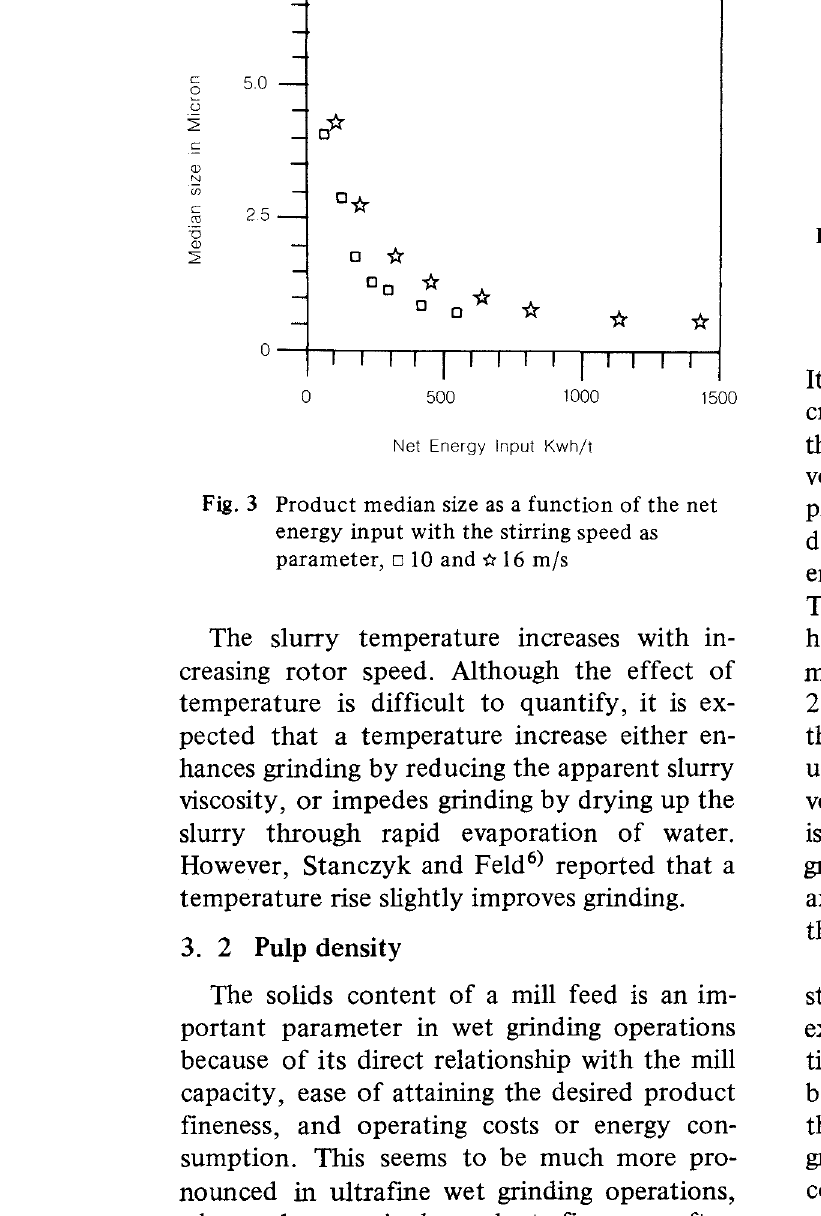
Fig. 4 Product size distributions with solids concen tration as a parameter, -tr 8%, o 13%, Li 26% and + 36% volume